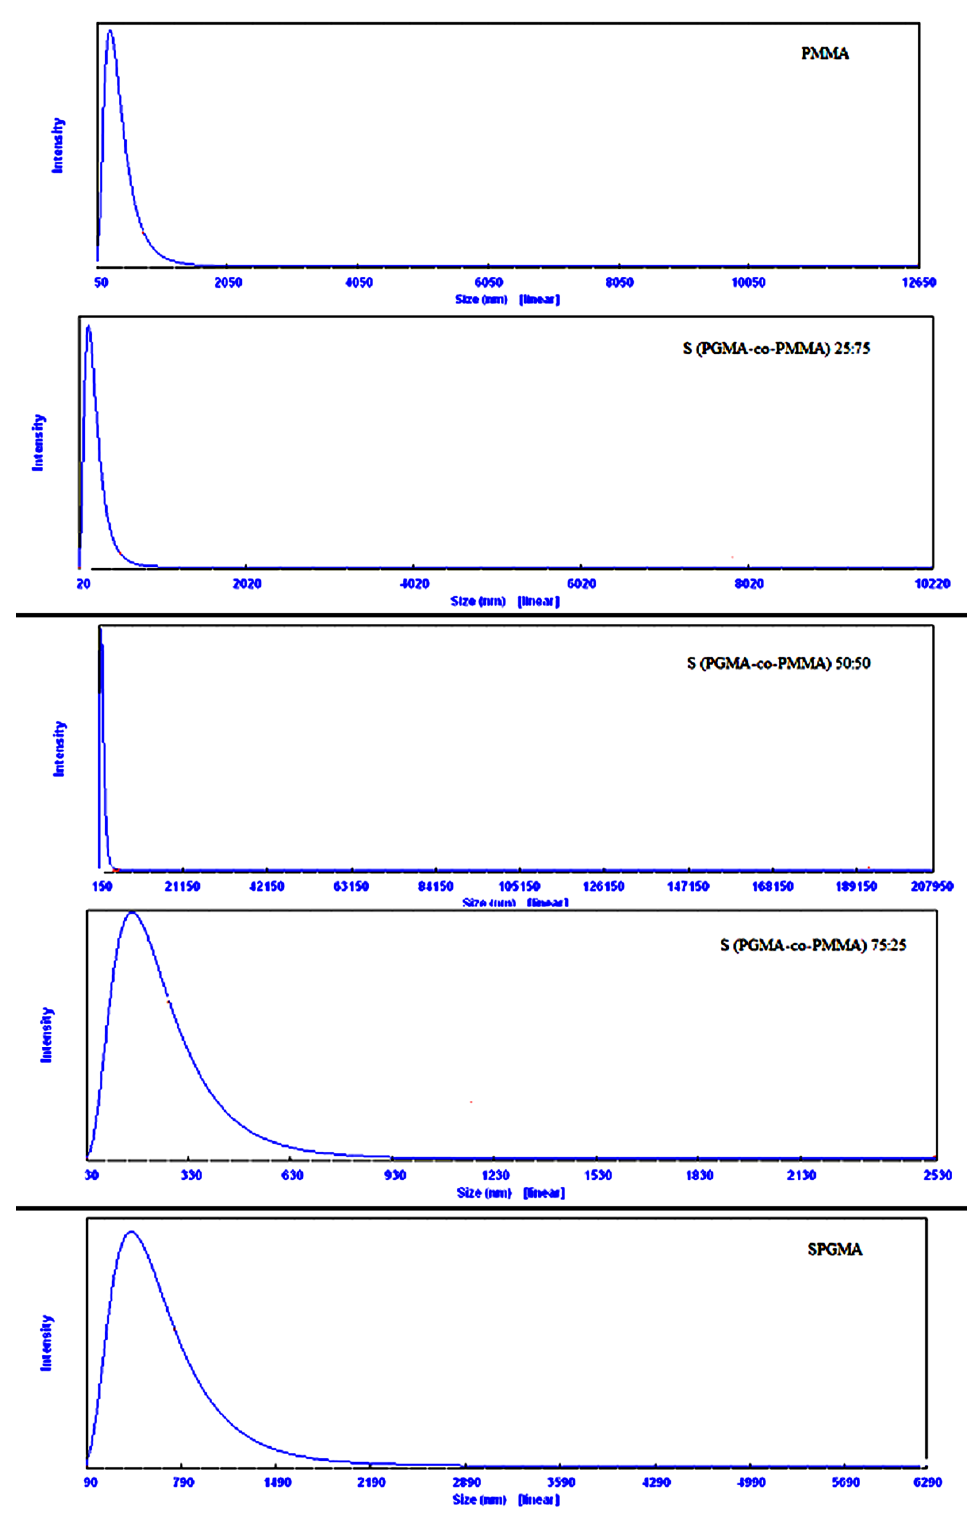
Figure 6. Effect of the comonomer composition on the particles size of the SPGMA based copoly- mers.